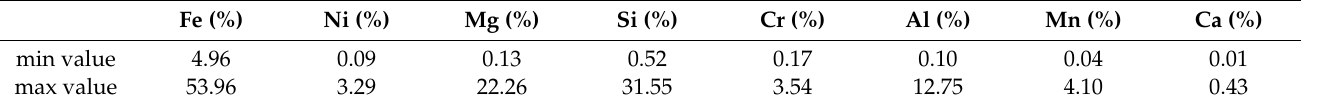
Table 2. Minimum (min) and maximum (max) values of reference samples concentrations.